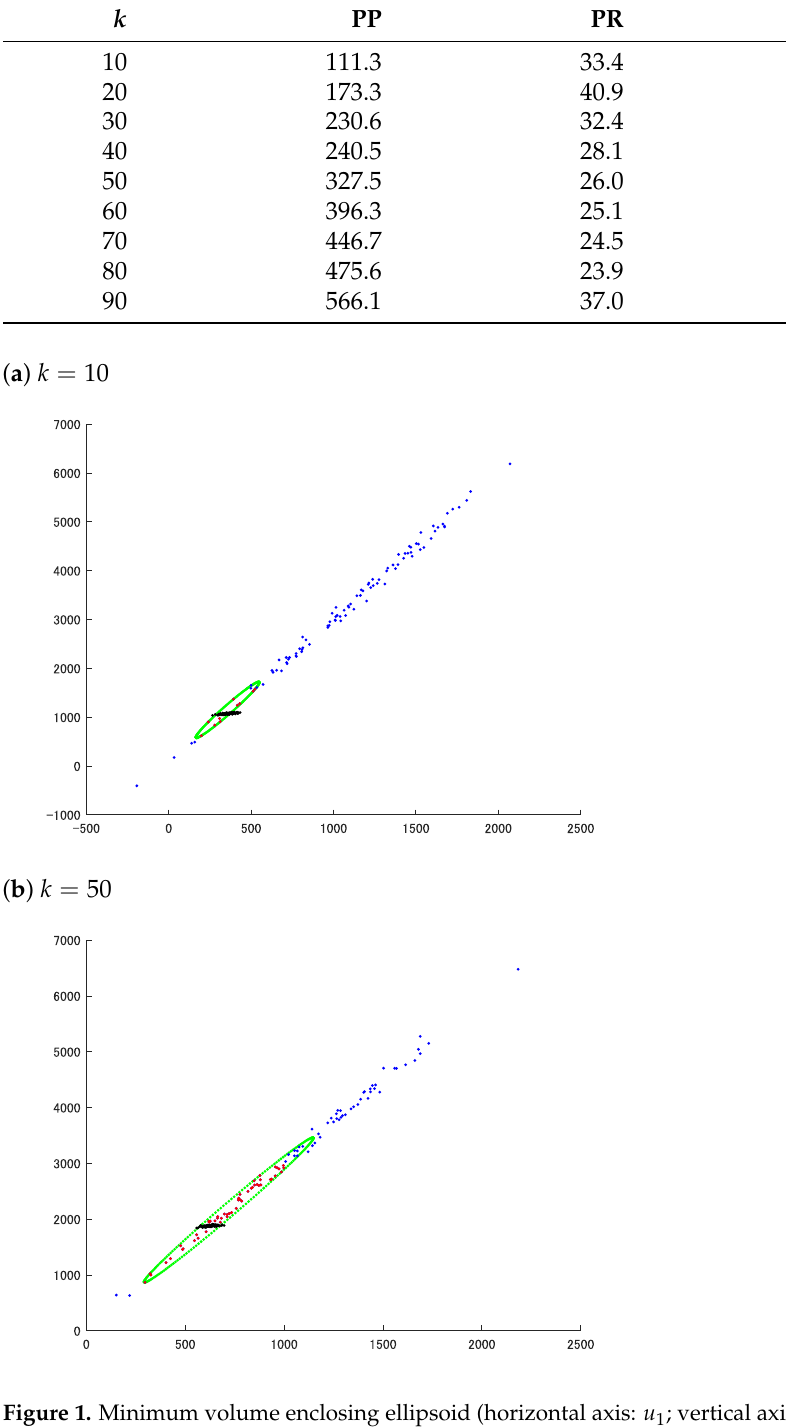
Figure 1. Minimum volume enclosing ellipsoid (horizontal axis: u 1 ; vertical axis: u 2